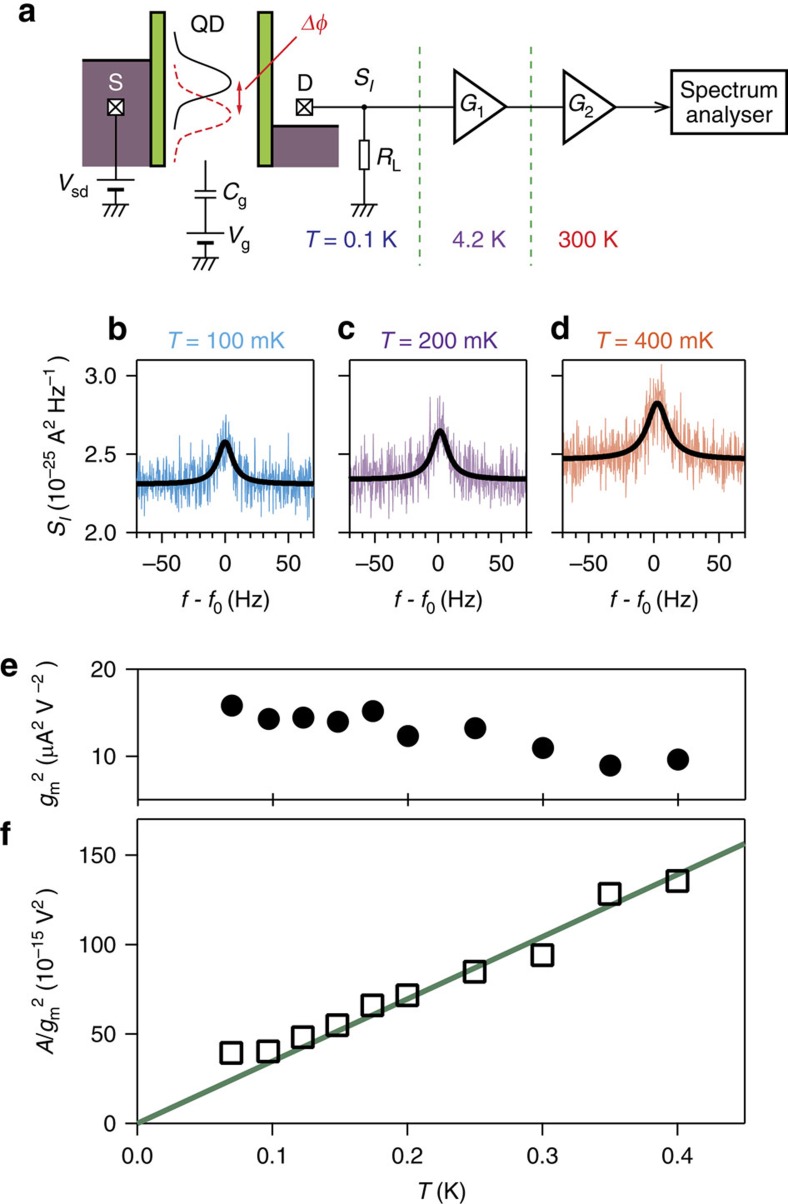
Thermal motion measured via the quantum dot current.(a) A schematic of the experimental setup for measuring thermal motion of the mechanical resonator. The potential fluctuation Δϕ induced by the piezoelectric field associated with the mechanical thermal motion results in current fluctuations, which are fed into a load resistor RL=1 kΩ and the voltage drop across the load is amplified by cryogenic (G1) and room-temperature (G2) amplifiers (see Methods). The resultant amplified signal is measured with a spectrum analyser. (b–d) The current power spectral density SI around f0 at three different temperature. The bold solid line shows a Lorenzian fit, from which the peak area A corresponding to the squared amplitude of the mechanical motion is obtained. (e,f) Temperature dependence of the transconductance gm≡dI/dVsd (e) and A normalized by gm (f) along with a linear fit (solid line).